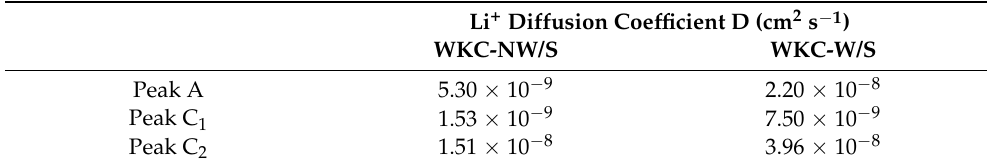
Table 2. Li + diffusion coefficients D (cm 2 s − 1 ) obtained for the discharge and charge processes for WKC-NW/S and WKC-W/S cells.